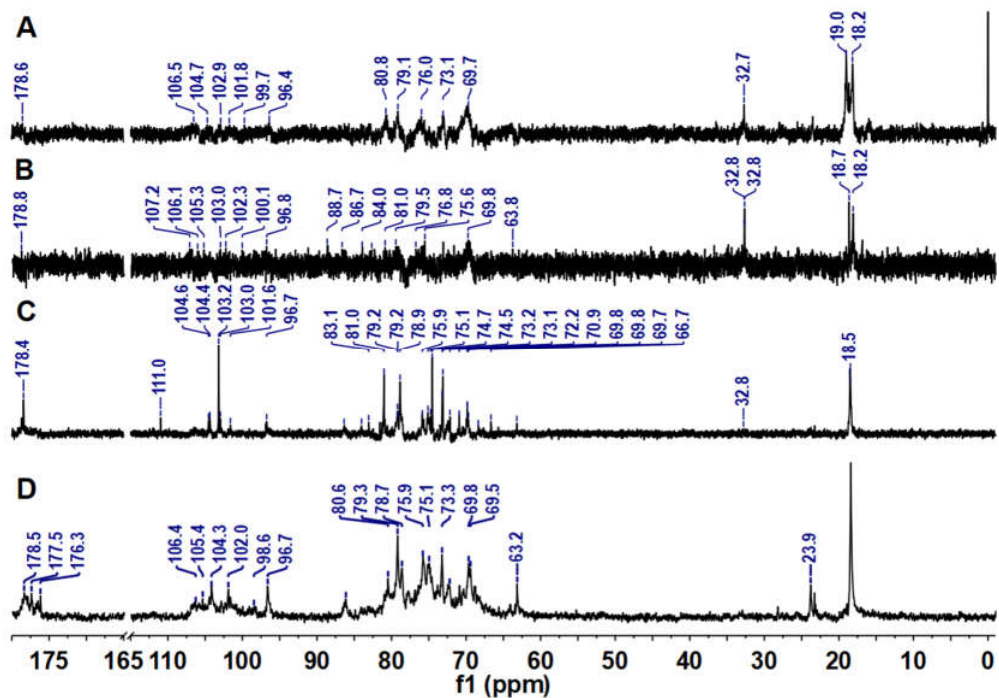
Figure 3. 13 C NMR spectra of LJPs ( A ), LJP0 ( B ), LJP04 ( C ), and LJP06 ( D ).